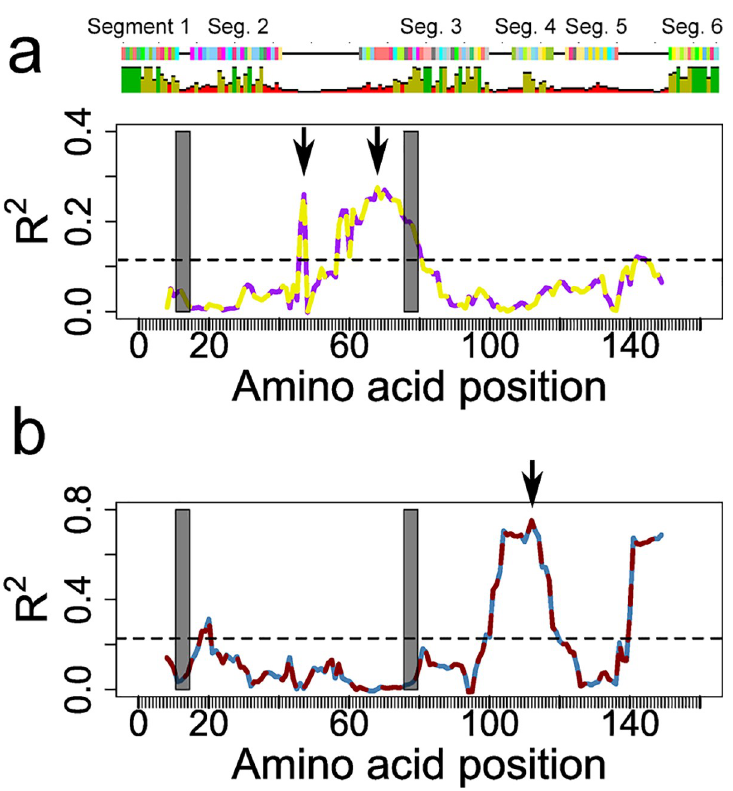
Fig 6. Sliding window analysis for regions of sequence that predict antigenic and genetic clusters. Correspondence (y-axis, measured by R 2 ) between genetic sub-maps built from sequence similarity in 14-residue windows (x-axis, midpoint of window) and a , serological clusters; and b , genetic clusters. Positions (window midpoints) that best define serological and genetic clusters, respectively, are shown with vertical arrows. Horizontal dashed lines in a and b indicate the P = 0.05 significance level for R 2 from permutation tests. PoLV1 and PoLV2 positions are indicated by grey boxes. The consensus sequence is shown at the top of panel a